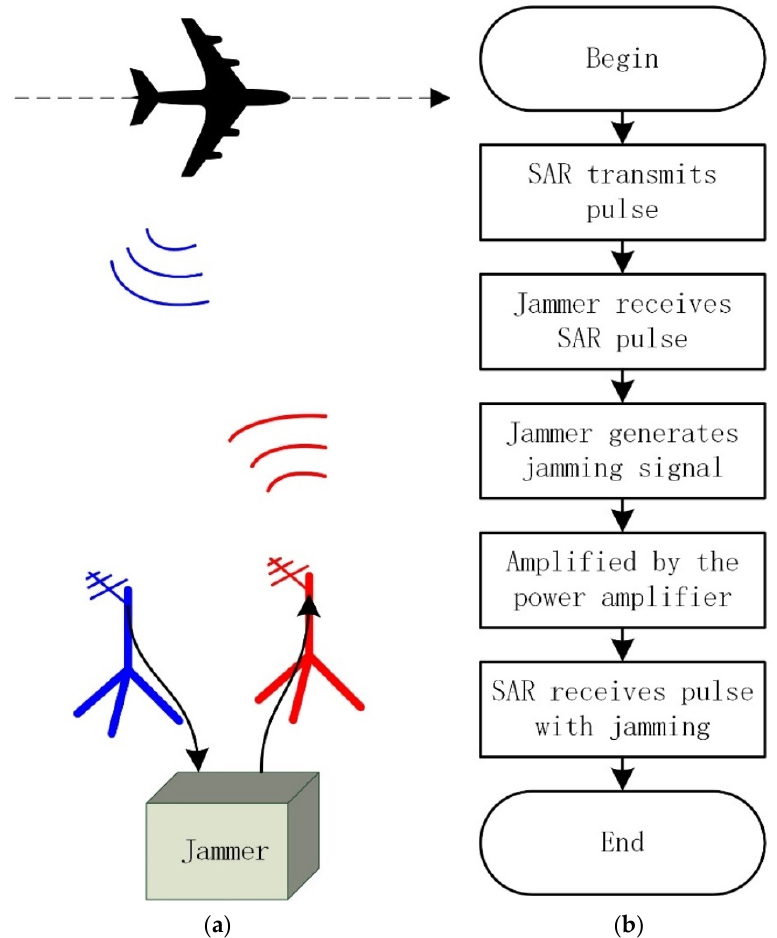
Figure 14. The schematic diagram and processing chain. ( a ) Schematic diagram. ( b ) Processing